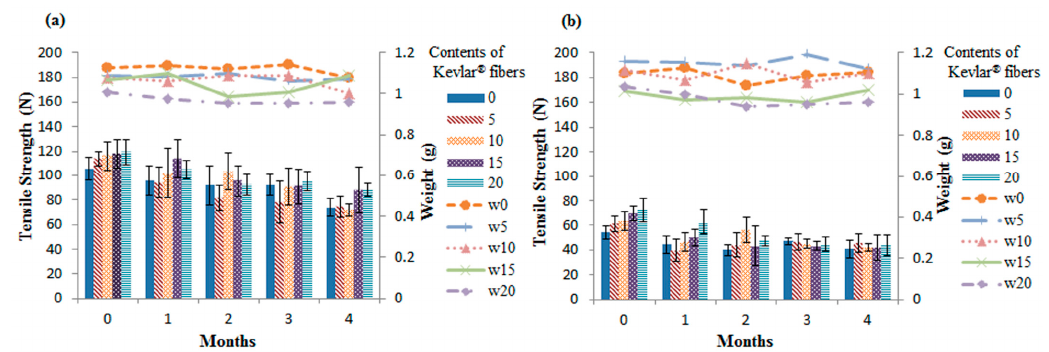
Figure 4. Tensile strength and weight along the (a) CD and (b) MD of recycled Kevlar ® /PET/LPET